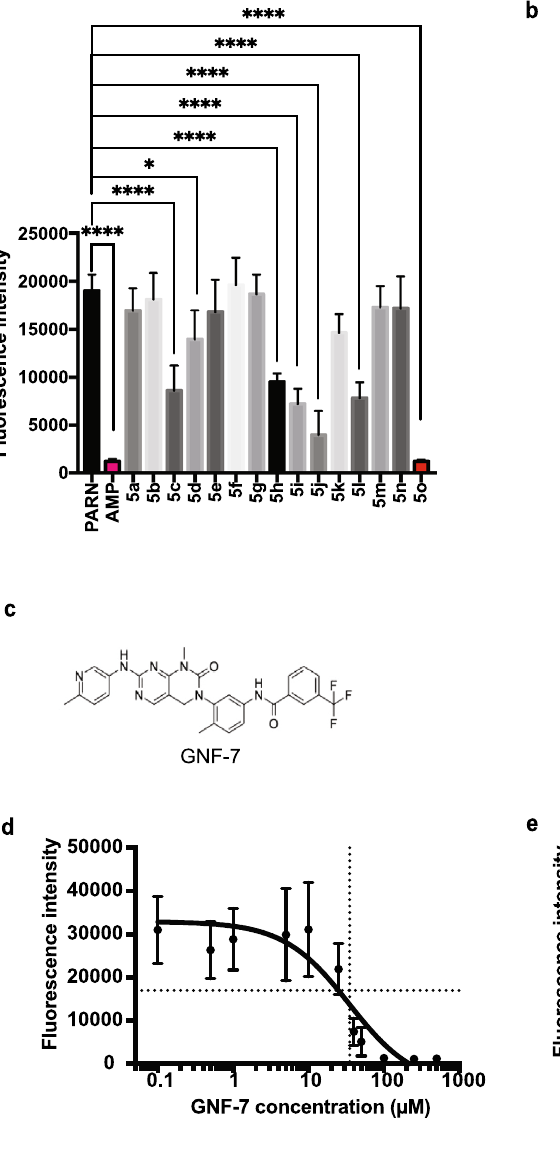
suggesting compound 8j may be a good candidate for PARN inhibitor as well. The remainder of these previ- ously identified PARN inhibitors were either tested with a different substrate (poly(A)) or their IC50s were not determined making a direct comparison between the effectiveness of these inhibitors on the activity of PARN difficult 30,32–34 .